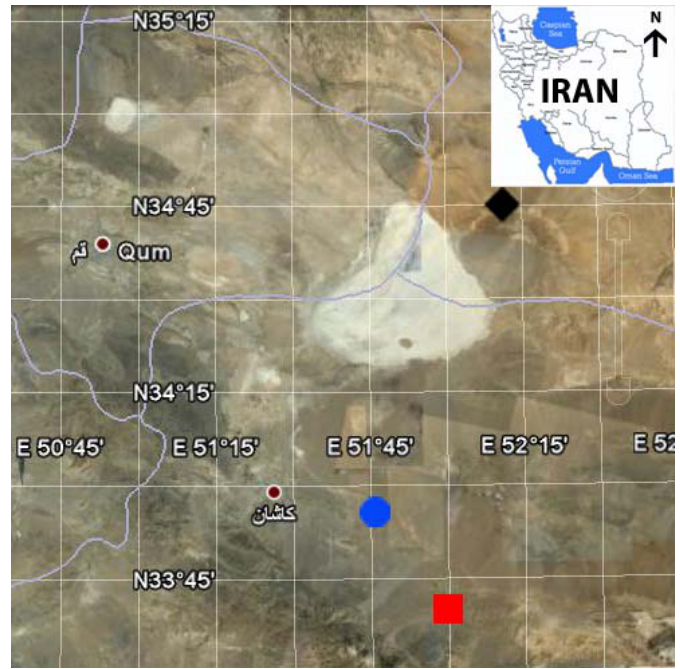
F IGURE 1. Localities of collected specimens of Ophiomorus nuchalis , black (diamond), type Locality (Nilson and Andren, 1978); red (squares), specimen from Arisman (ZMGU.2579); blue (circle), specimen from Abouzeid Abad